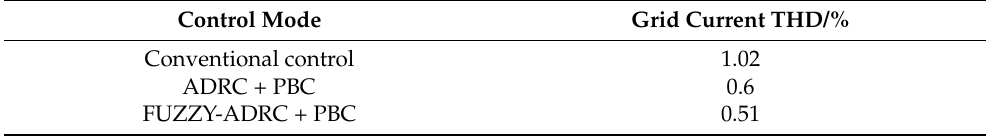
Table 3. THD analysis of grid-connected current under strong grid conditions.